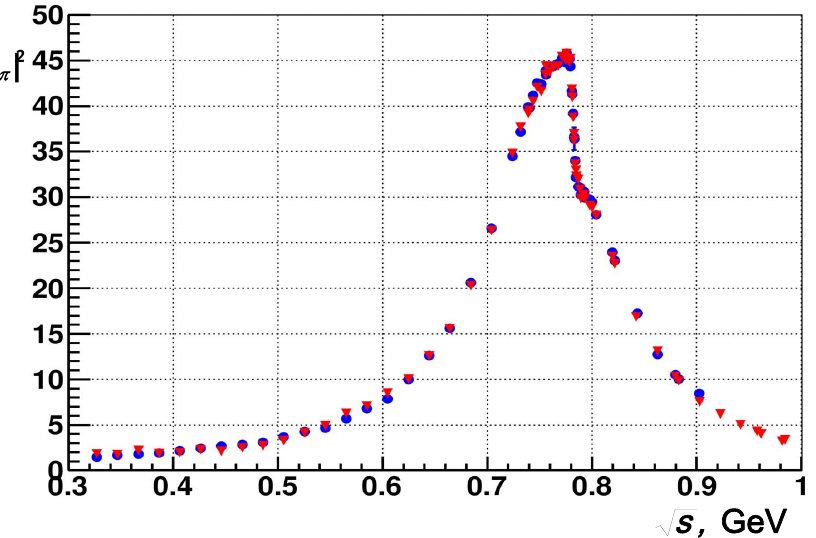
Figure 3: Preliminary results (still blinded!) of CMD-3 study of the π + π − channel. Triangles (red) – separation by energy deposition in the calorimeter ; circles (blue) – separation by the particle